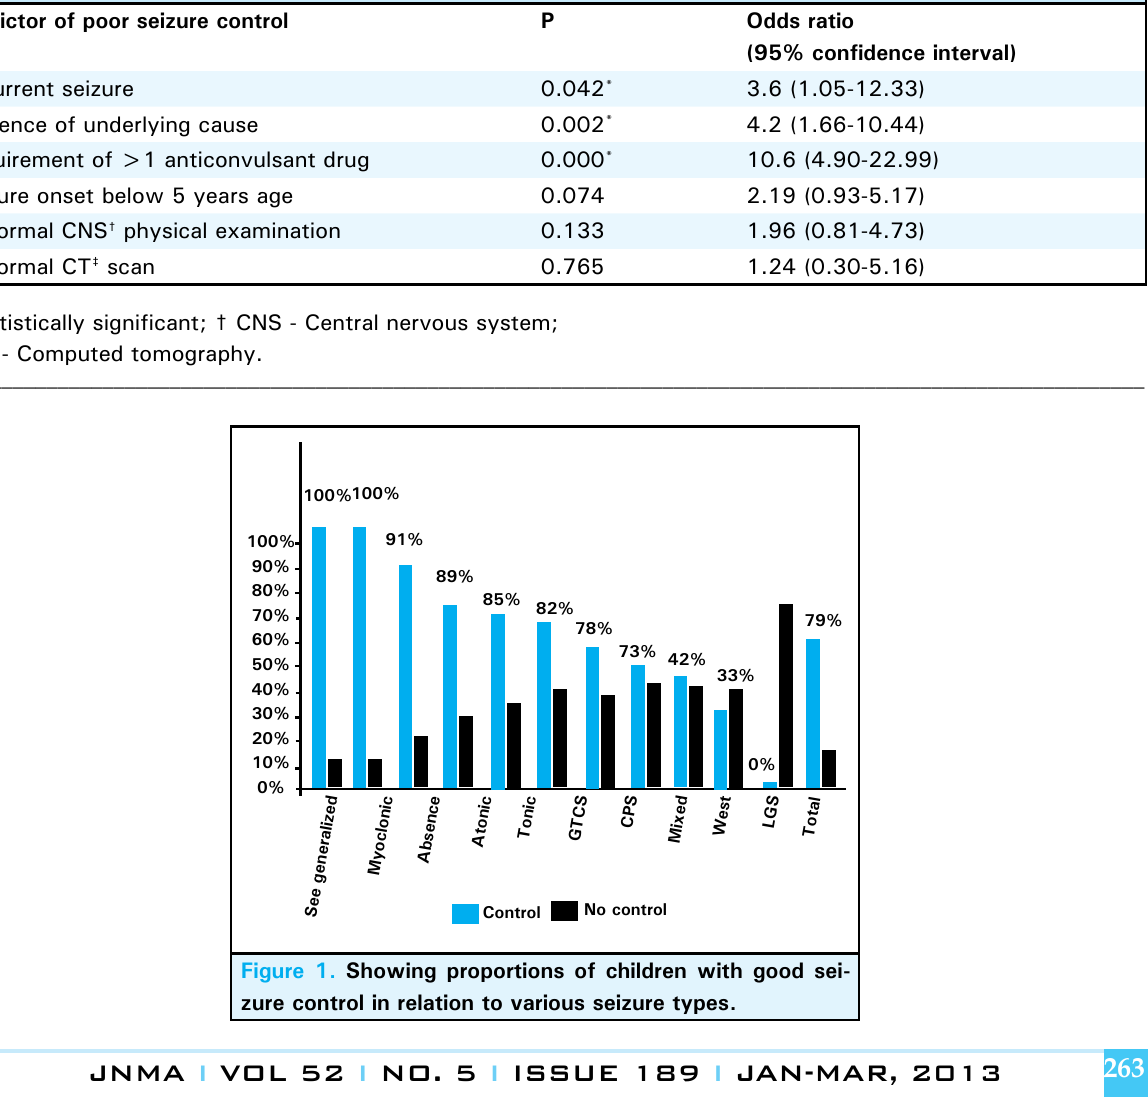
Table 6 . Predictors of outcome on binary logistic regression.